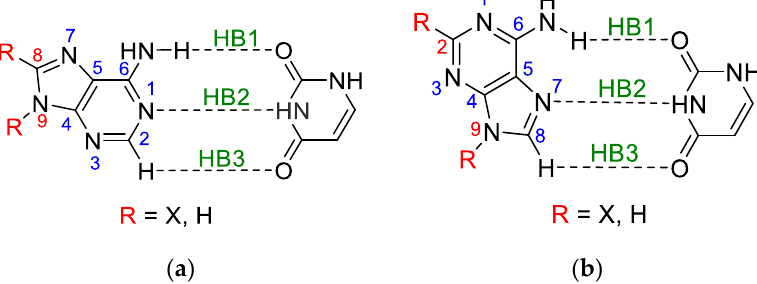
Figure 1. Adenine-uracil ( a ) Watson-Crick (abbreviated as WC) and ( b ) Hoogsteen (abbreviated as HG) base pairs with the common numbering of adenine atoms and adopted hydrogen bond numeration. Substitutable positions are marked in red color.